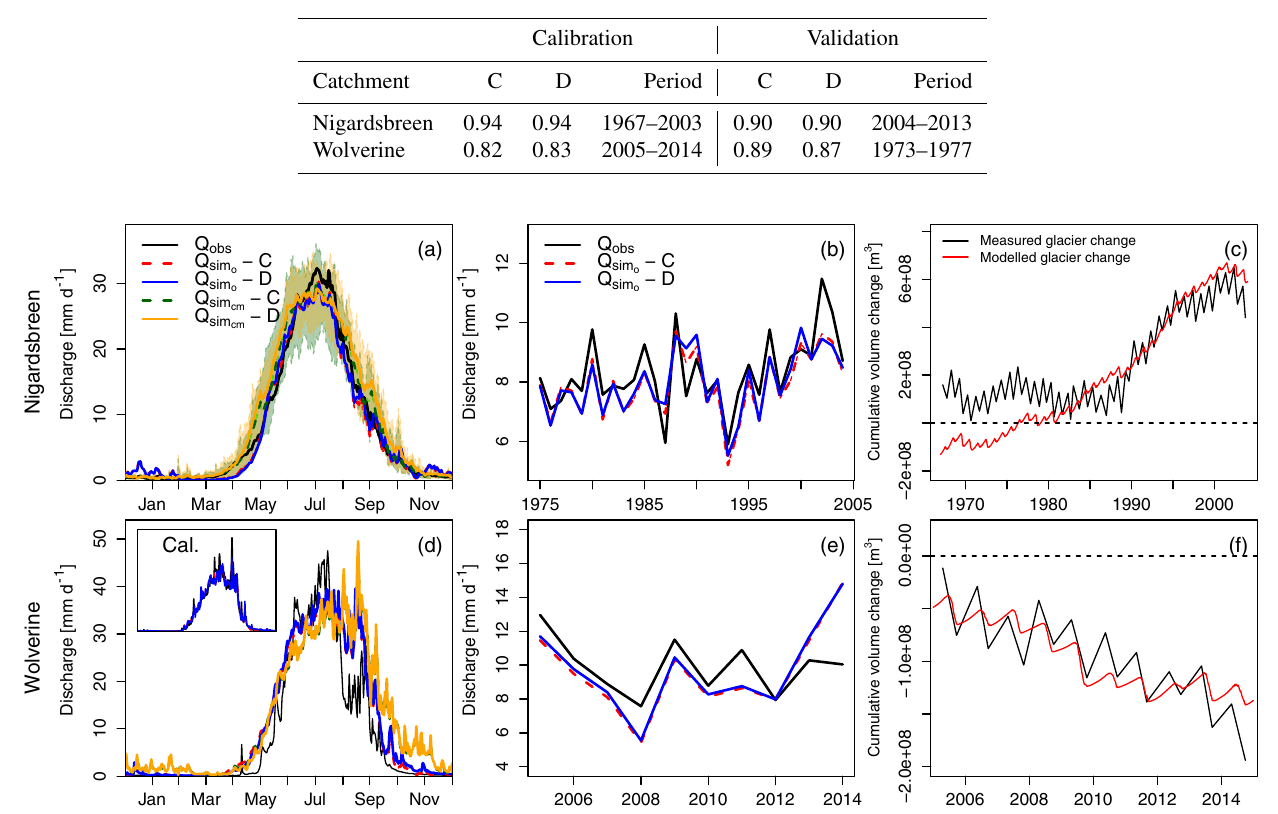
Table 1. Model performance for the two catchments. Performance is expressed by KGE between observed and modelled discharge and shown for the calibration and validation periods and the dynamic (D) and constant (C) glacier area conceptualisations.